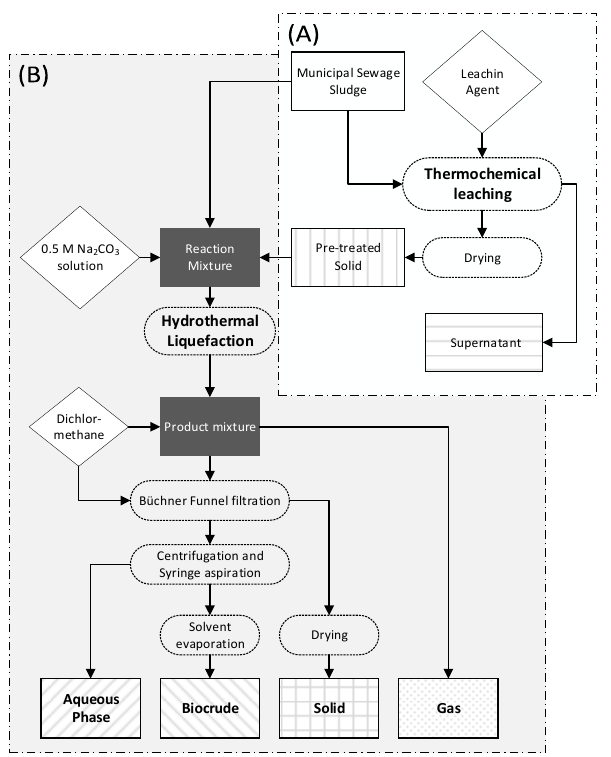
Figure 1. Process procedure: ( A ) pre-treatment and ( B ) hydrothermal liquefaction (HTL) process, including product separation.